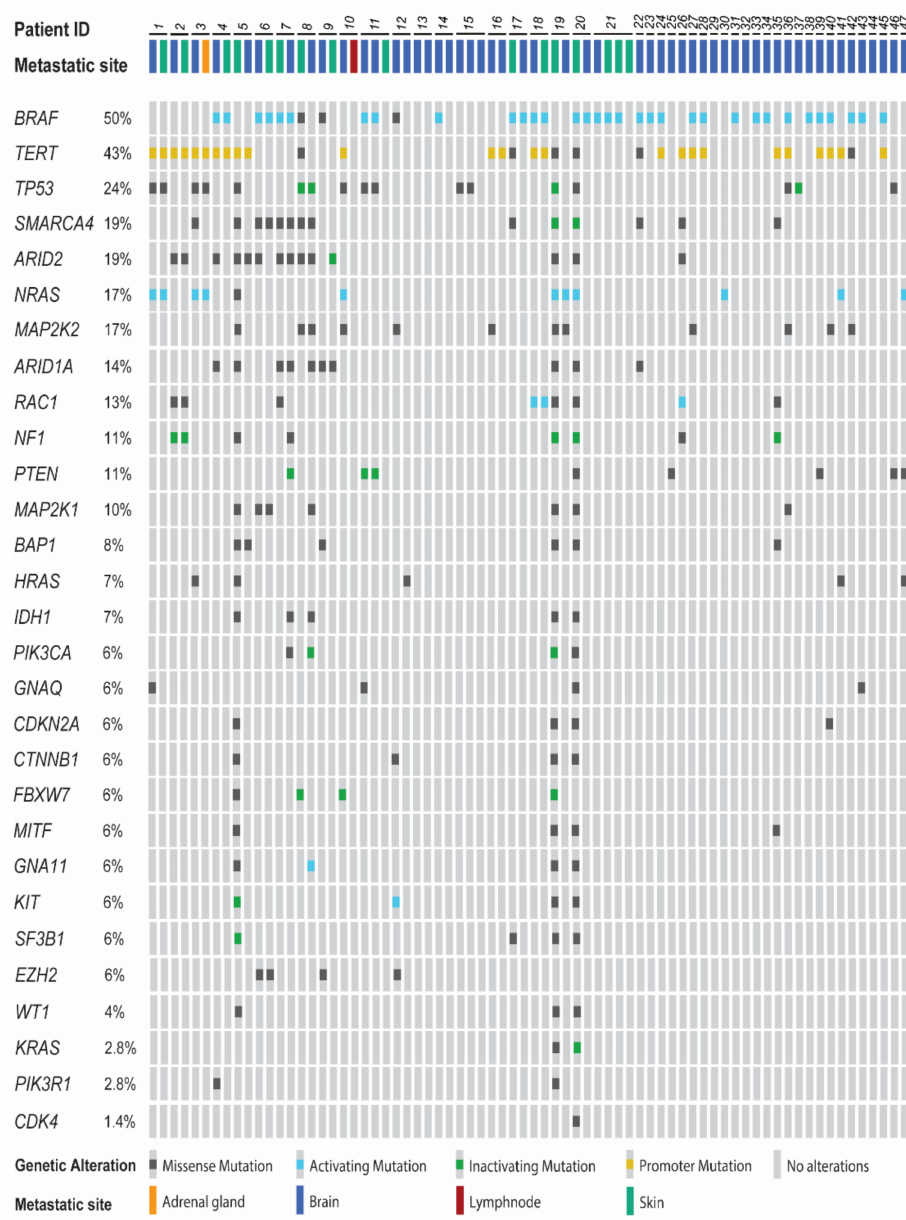
Figure 1. OncoPrint chart displaying the type of detected genomic alterations in the 29 gene-panel across 72 sequenced melanoma metastases. Patient identification (ID) numbers are given. Each column represents a sample, sample type is indicated at the top in a color-coded manner. The percentage of samples with detectable alteration is listed on the left for each